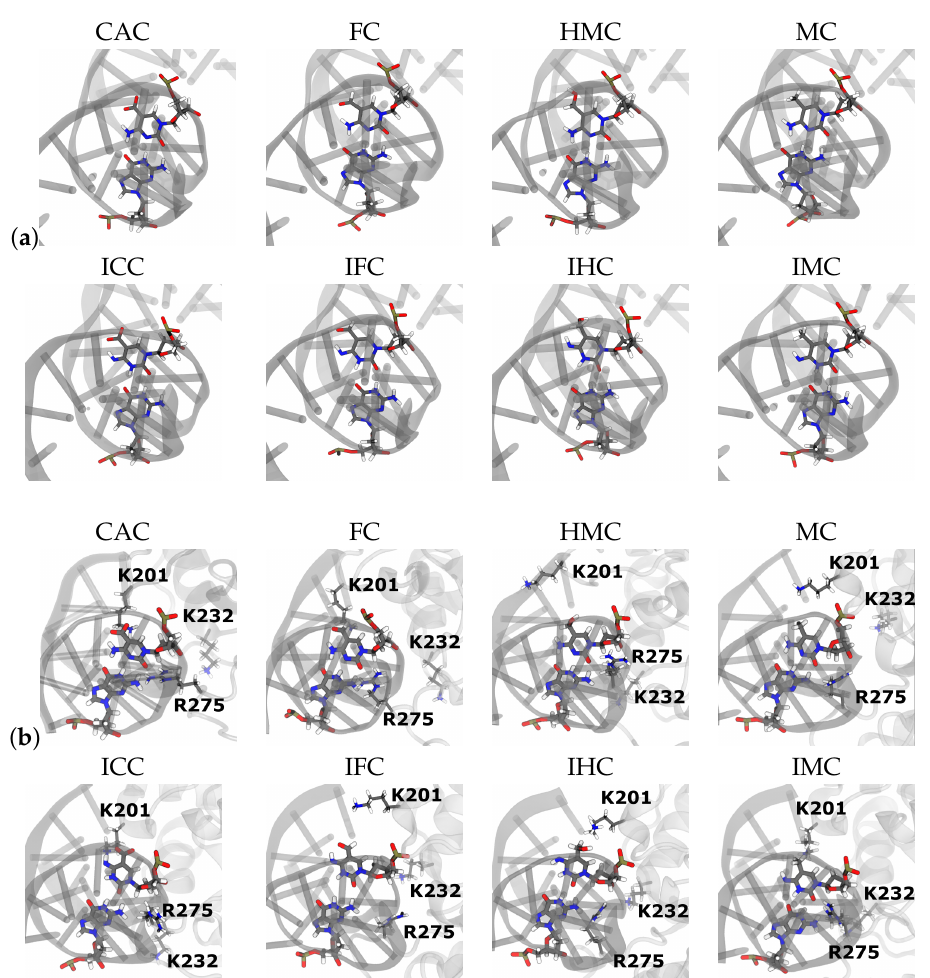
Figure 9. Snapshots of the G:XC pair ( a ) in free DNA and ( b ) in DNA complexed to TDG. Analysis of interactions between water and the bases of the G:XC lesion, in terms of hydrogen bonds, shows a few obvious differences such that HMC and IHC are the only systems in which the XC base is a hydrogen bond donor to a water molecule and hydrogen bonds with oxygen atom O16 can only occur in the CAC and ICC systems since only the carboxyl group has this second oxygen atom. Likewise, MC and IMC lack oxygen atom O15 and therefore cannot accept a hydrogen bond from a water molecule with the methyl group (see Figure 2). It is interesting to note, however, that O15 acts also as hydrogen bond acceptor in the amino tautomer HMC, in free and complexed form, but only in the free DNA also in the imino tautomer IHC (see Table